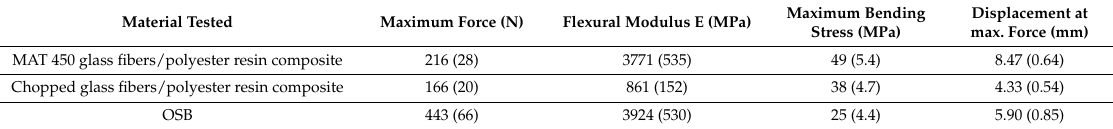
Table 4. Properties of materials corresponding to each layer of the manhole cover structure.